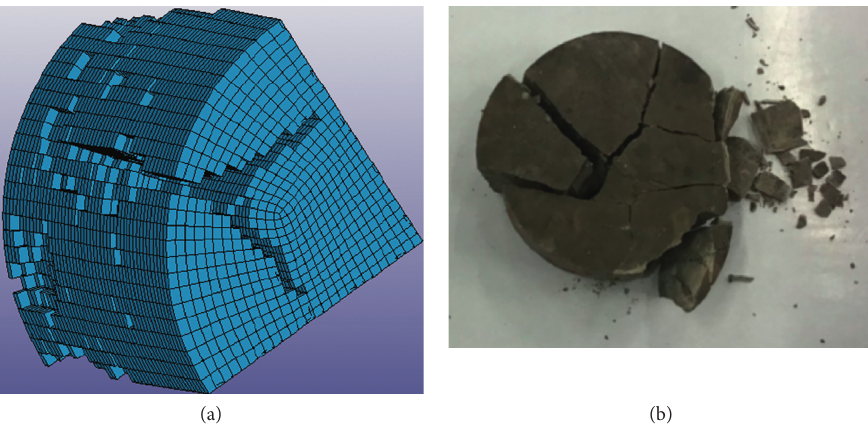
Figure 11: Failure modes of freeze-thaw cycle sandstone at 0.07MPa impact pressure. (a) Typical failure patterns of a quarter of the specimen under numerical simulation. (b) Typical failure modes of laboratory test specimens.